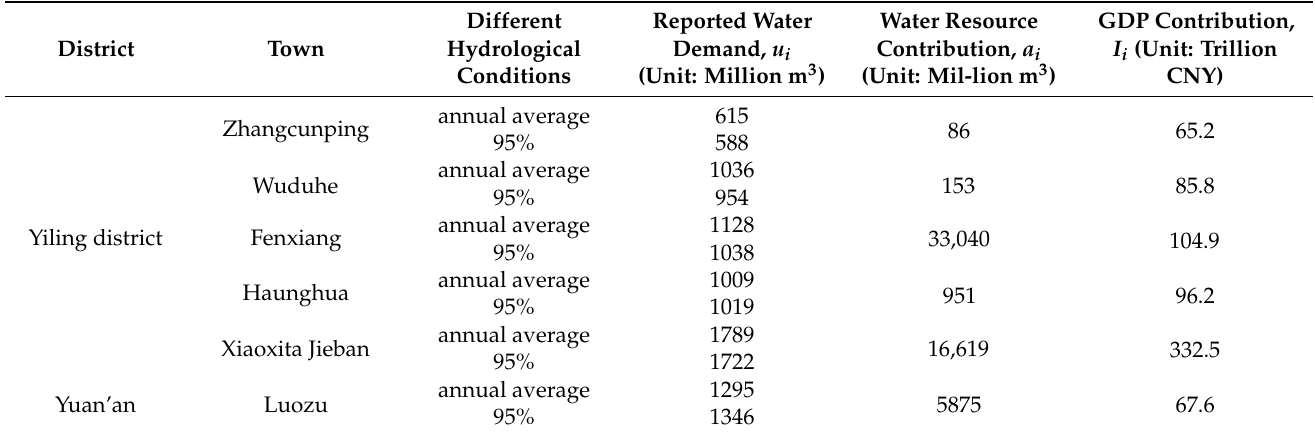
Table 1. Basic information of Huangbai River.